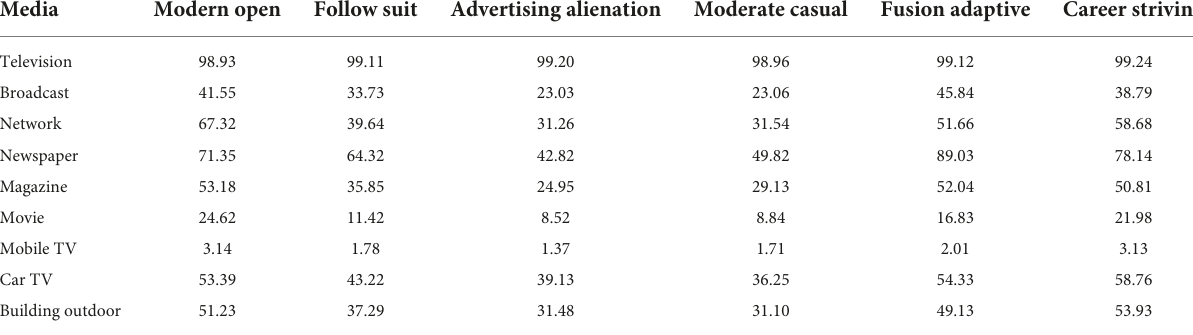
TABLE 3 Proportion of audiences with different forms of exposure to different